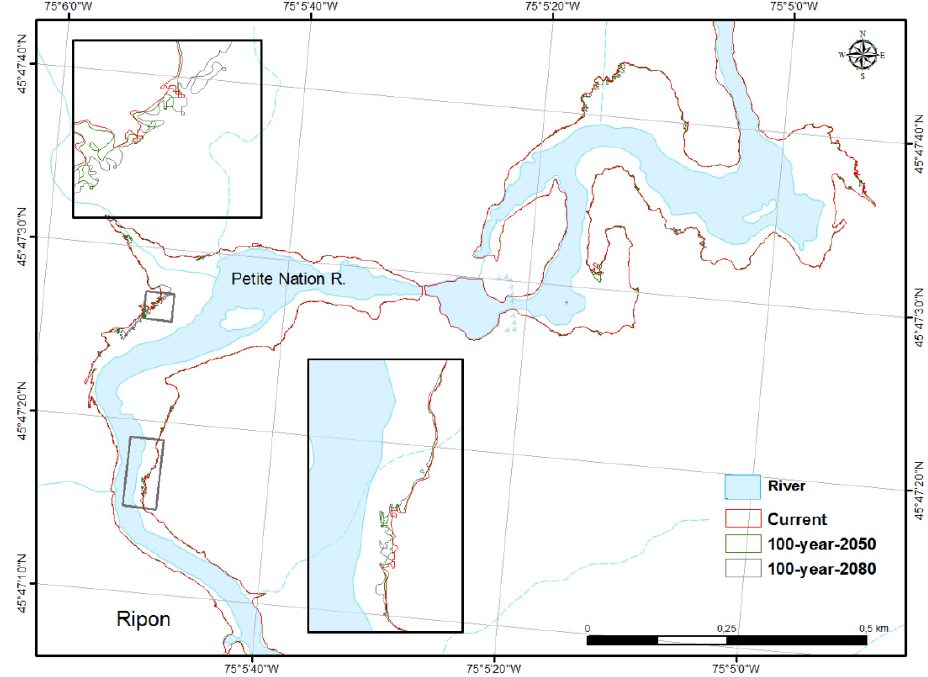
Figure A2. Flood extent for a 100-year return period, under current, 2050, and 2080 horizons (RCP 8.5). Case: